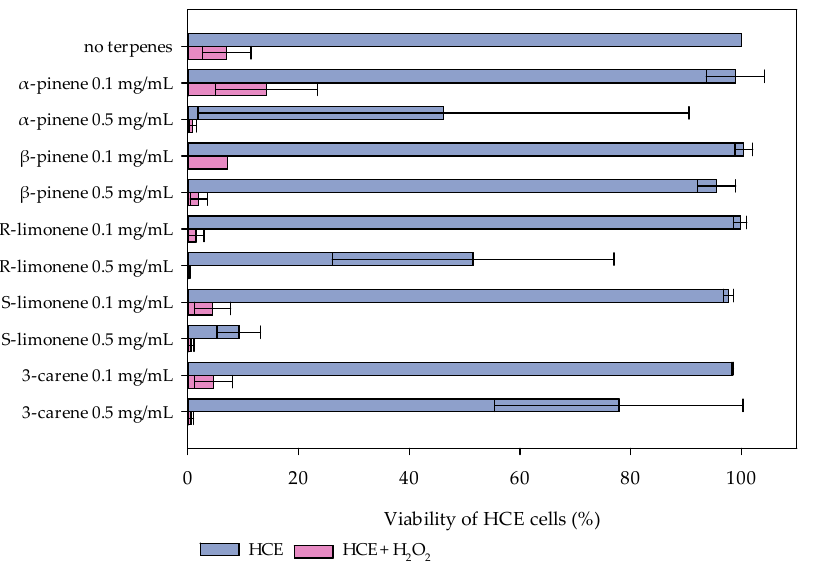
Figure 2. Cytotoxicity results for α - and β -pinene, R- and S-limonene, and 3-carene in the HCE cell model measured with a WST-1 test. The values represent average cell viabilities from one to three repeated measurements with monoterpene concentrations of 0–5000 µg/mL. Results obtained with control cells were set as 100%.